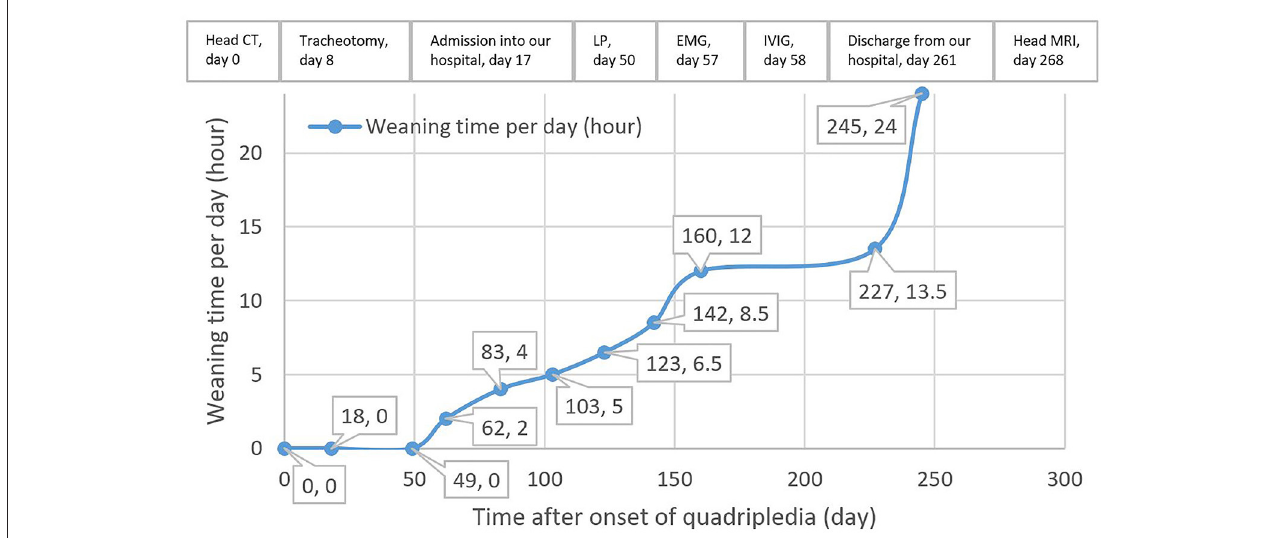
FIGURE 1 | Weaning time and timeline of the management of the patient after onset of quadriplegia. CT, computed tomography; LP, lumbar puncture; EMG, electromyography; IVIG, intravenous immunoglobulin; MRI, magnetic resonance